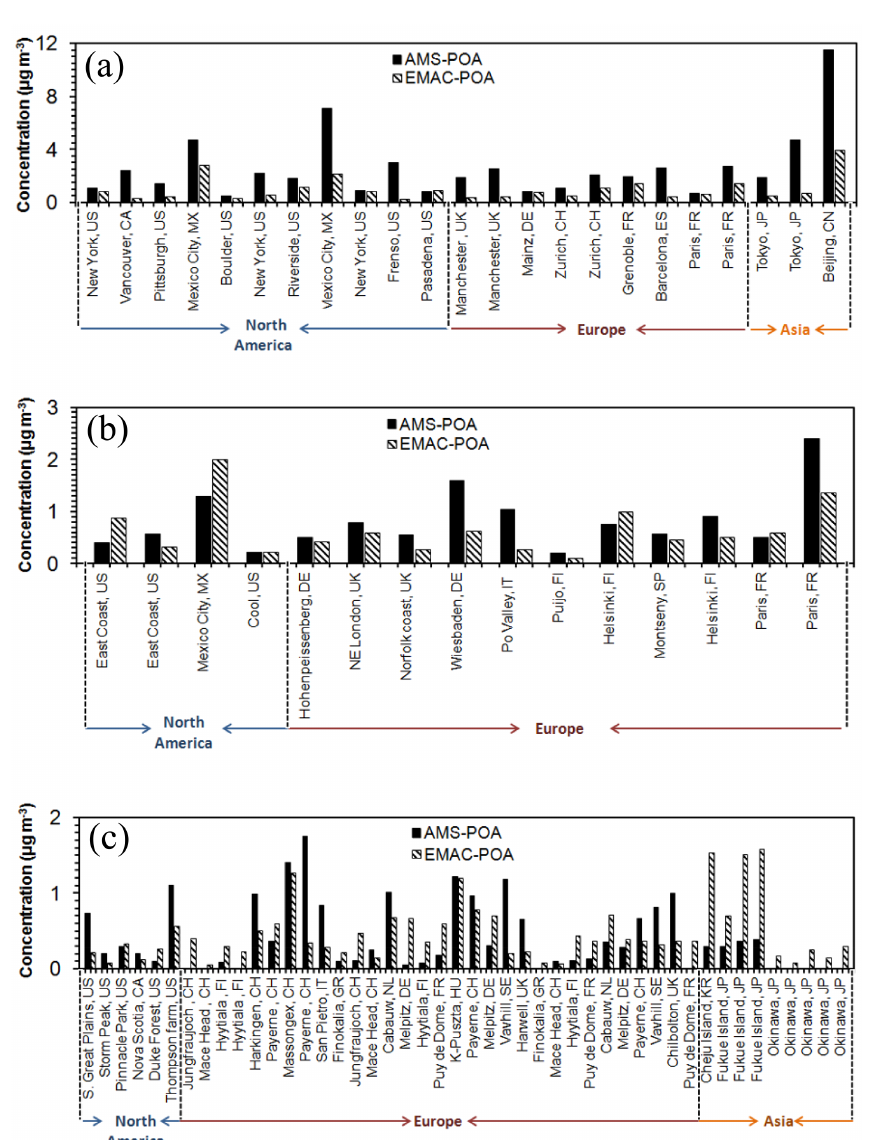
Figure 11. Comparison of EMAC POA (sum of fPOA and bbPOA) to AMS POA (sum of HOA and BBOA) from 84 data sets worldwide over (a) urban, (b) urban downwind, and (c) rural/remote areas during